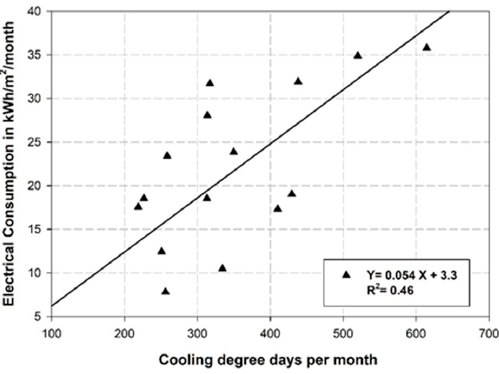
Figure 3. Monthly electrical consumption in kWh/m 2 /month versus cooling degree-days per month in the University of Jeddah from March 2017 to June 2018. A linear fit and correlation are